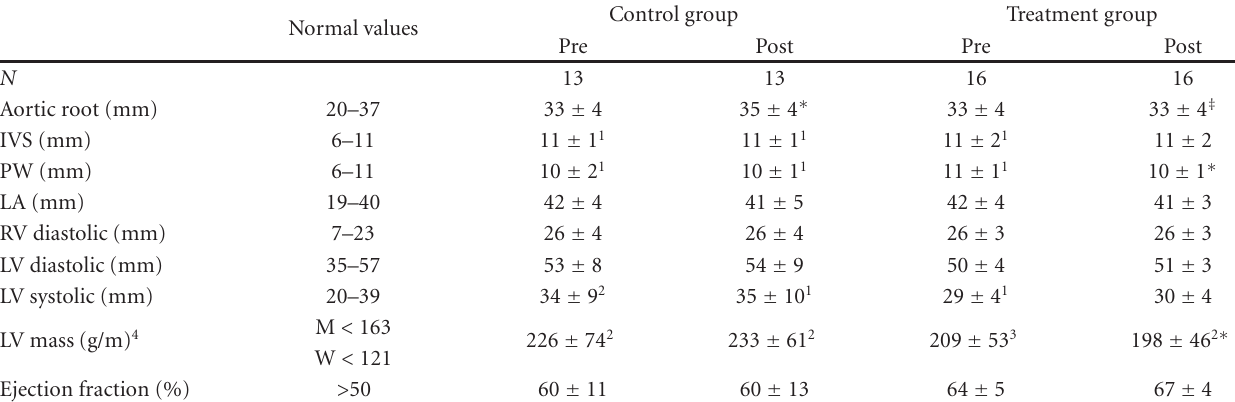
Table 3: Echocardiographic parameters in severely obese subjects with type 2 diabetes before and after treatment. Normal